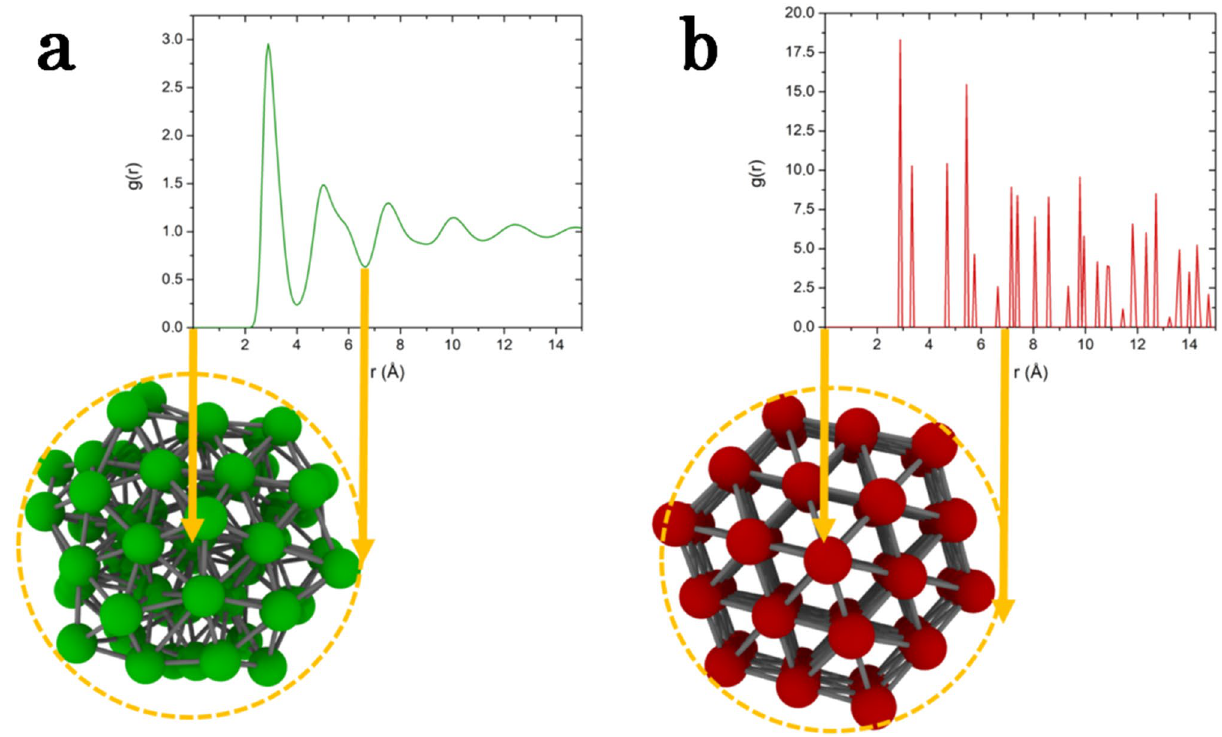
Figure 5. Cut-off radius for the clustering based on the g ( r ) function with the second minimum leading to structures with two neighbors shells with the one associated in Ta to the preponderant liquid in green ( a ) and the one to bcc ordering in red ( b